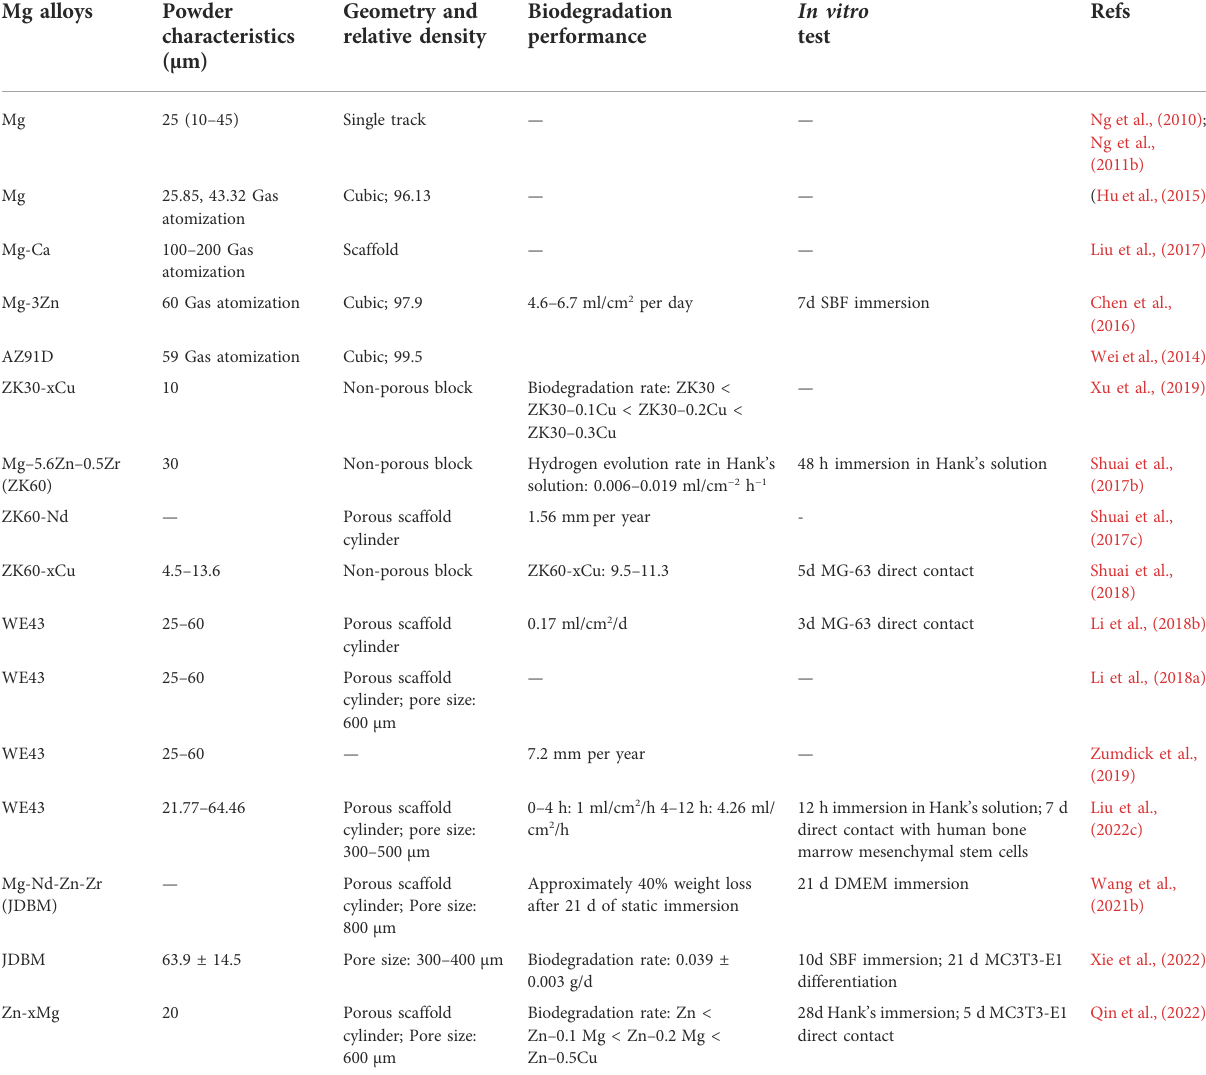
TABLE 2 Summary of the recent biodegradation performance of L-PBF Mg-based